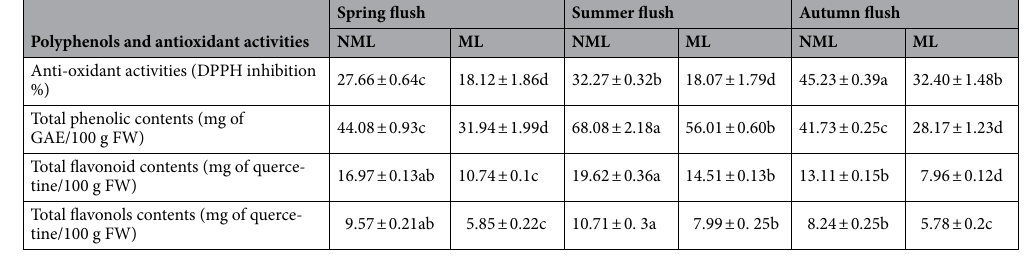
Table 11. Antioxidant activity and polyphenols in non-mined leaves (NML) and mined leaves (ML) of three vegetative flushes. Results were reported in means (± SD). Means sharing dissimilar letters are significantly differed according to LSD test ( P ≤ 0.05) for three flushes non-mined and mined leaves parameters.